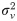
Independence of the firing rate on the electrotonic length λ for the one-dendrite model, and between the one and two-dendrite models for the same voltage variance.(a) The firing rate of the one-dendrite model with two different λ show it to be independent from λ. Here σs = 1mV. (b) If the synaptic noise amplitude σs is adjusted such that the one and two-dendrite models have the same voltage variance σv2 at the threshold position, then their upcrossing rates are identical. Simulations (circles and triangles for one and two-dendrite models respectively) suggest that the full firing rates are also independent of geometry in this case. Other parameters: τv = 10ms, τs = 5ms, vth = 10mV and vre = 0mV.